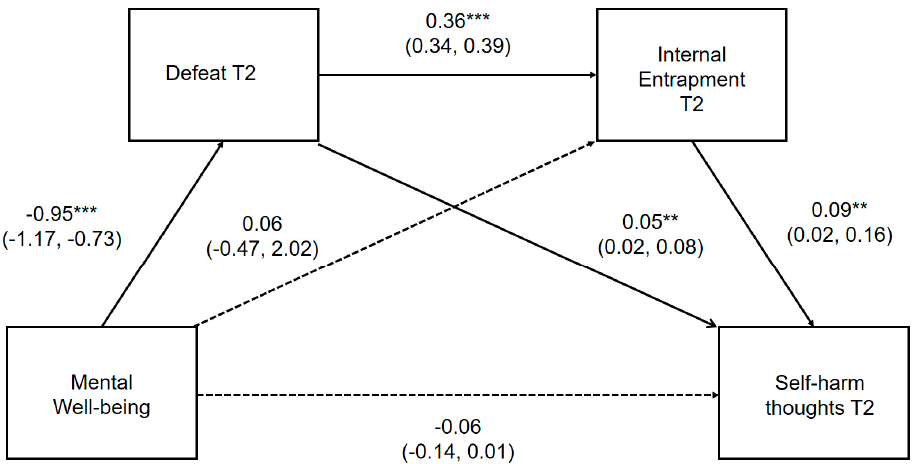
Figure 3. Serial multiple mediation model for the association between mental well ‐ being and prospective self ‐ harm thoughts, via defeat and internal entrapment. ** p < 0.01, *** p < 0.001 Serial multiple mediation model with unstandardized regression coefficients and 95% bias corrected confidence intervals. Significant pathways highlighted in bold.